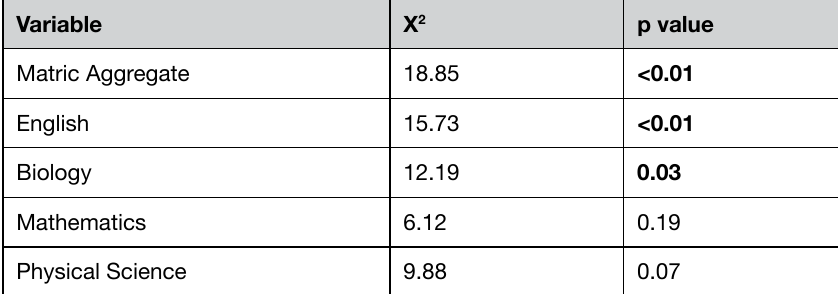
Table 1: high school performance and academic success in physiotherapy (n = 128)